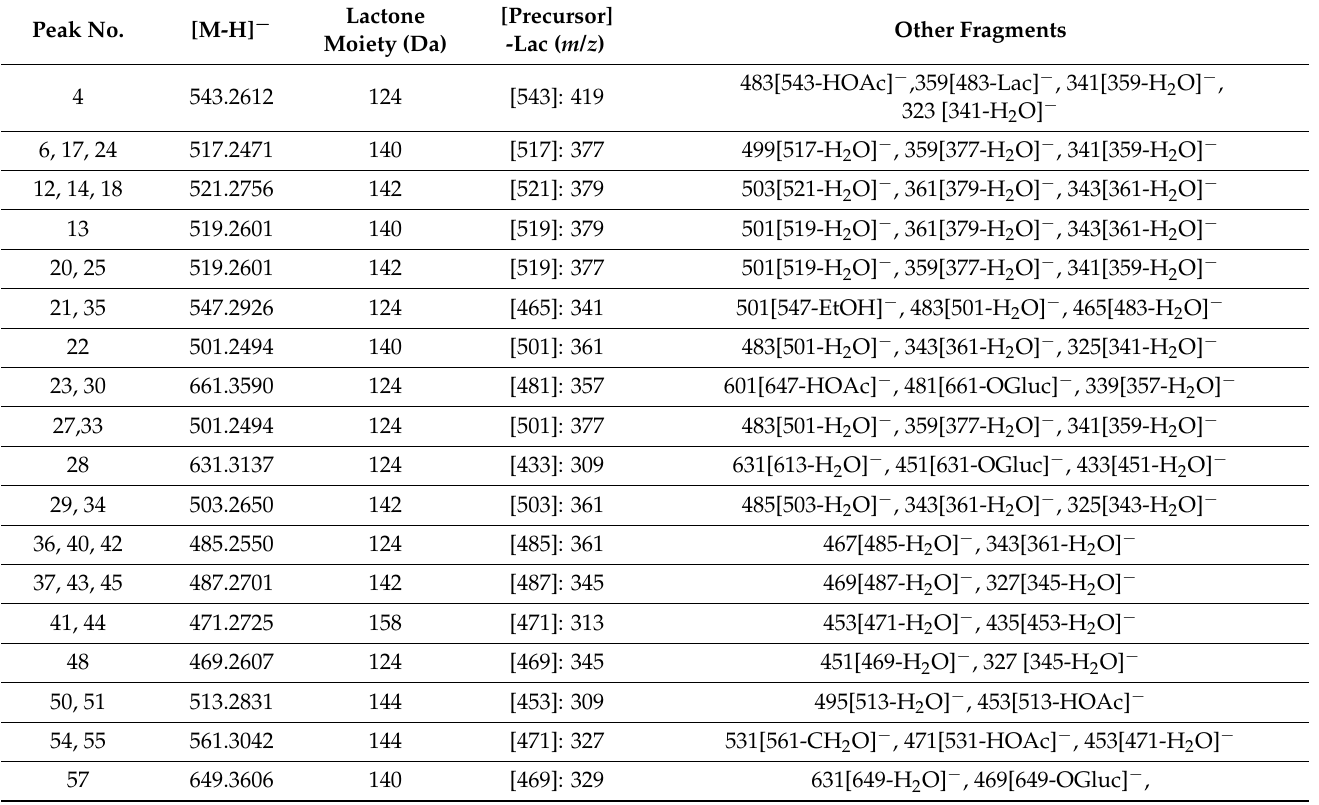
Table 1. UPLC-ESI-MS characterization of withanolides in Physalis peruviana samples from Costa Rica. Peak